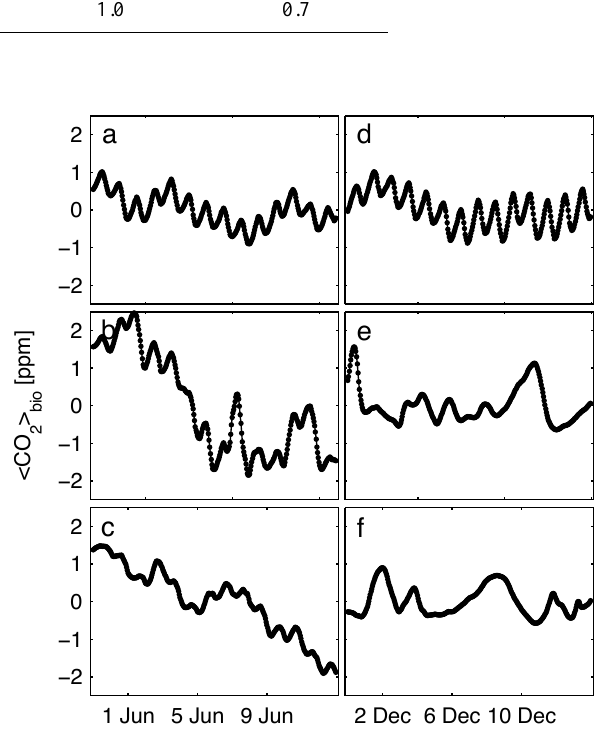
Fig. 4. Biospheric h CO 2 i bio sampled at three Northern Hemisphere gridboxes in June (left) and December (right). (a, d) Tropical Venezuela (3 ◦ N, 295 ◦ E). (b, e) Midlatitude (46 ◦ N, 270 ◦ E). (c, f) High latitude Alaska (65 ◦ N, 213 ◦ E). A diurnal cycle is evident at all sites during the summer, but it is dwarfed by synoptic-scale variability in mid- and high-latitudes. During the winter, only the tropical site shows a diurnal cycle in h CO 2 i bio .